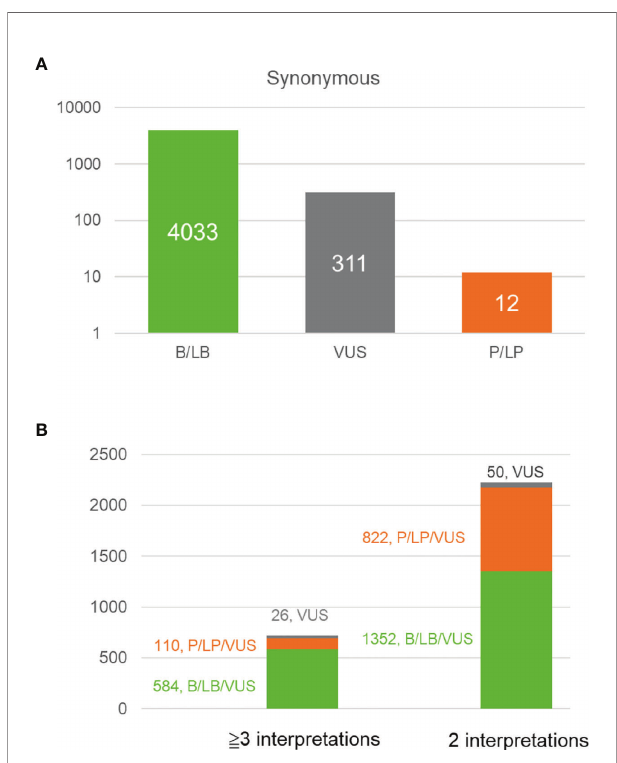
FIGURE 3 | Analysis of the variants in different classes recorded in BRCA exchange database (accessed in Aug. 2021, https://brcaexchange.org). (A) Bar plot showing the number of benign/likely benign variants (4033, in green), VUS (311, in gray), and pathogenic/likely pathogenic variants (12, in orange) in BRCA exchange database. (B) Bar plot shows the number of variants with different interpretations in the BRCA exchange database. Green, the variant with different interpretations of benign, likely benign or VUS; orange, the variant with different interpretations of pathogenic, likely benign and VUS; gray, the variants of